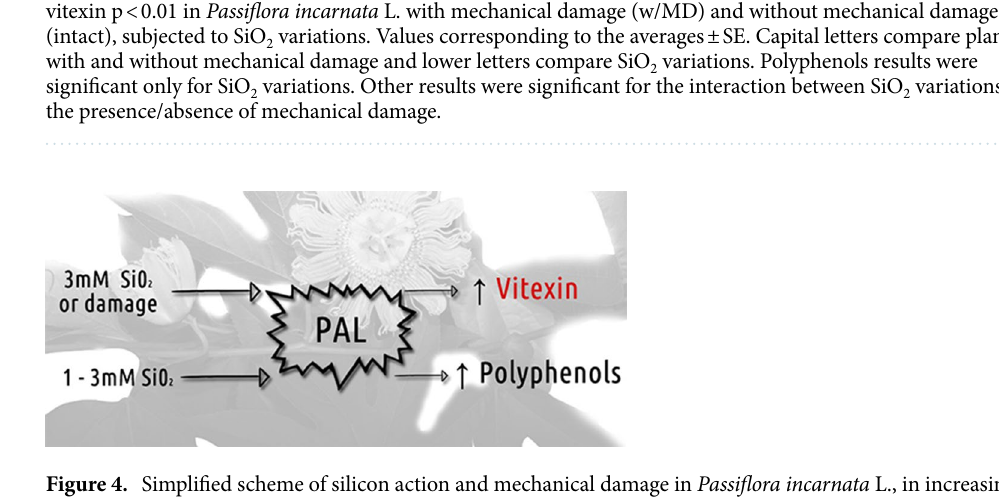
Figure 4. Simplified scheme of silicon action and mechanical damage in Passiflora incarnata L., in increasing the activity of the enzyme phenylalanine ammonia-lyase (PAL), resulting in an increase in polyphenols and vitexin 23